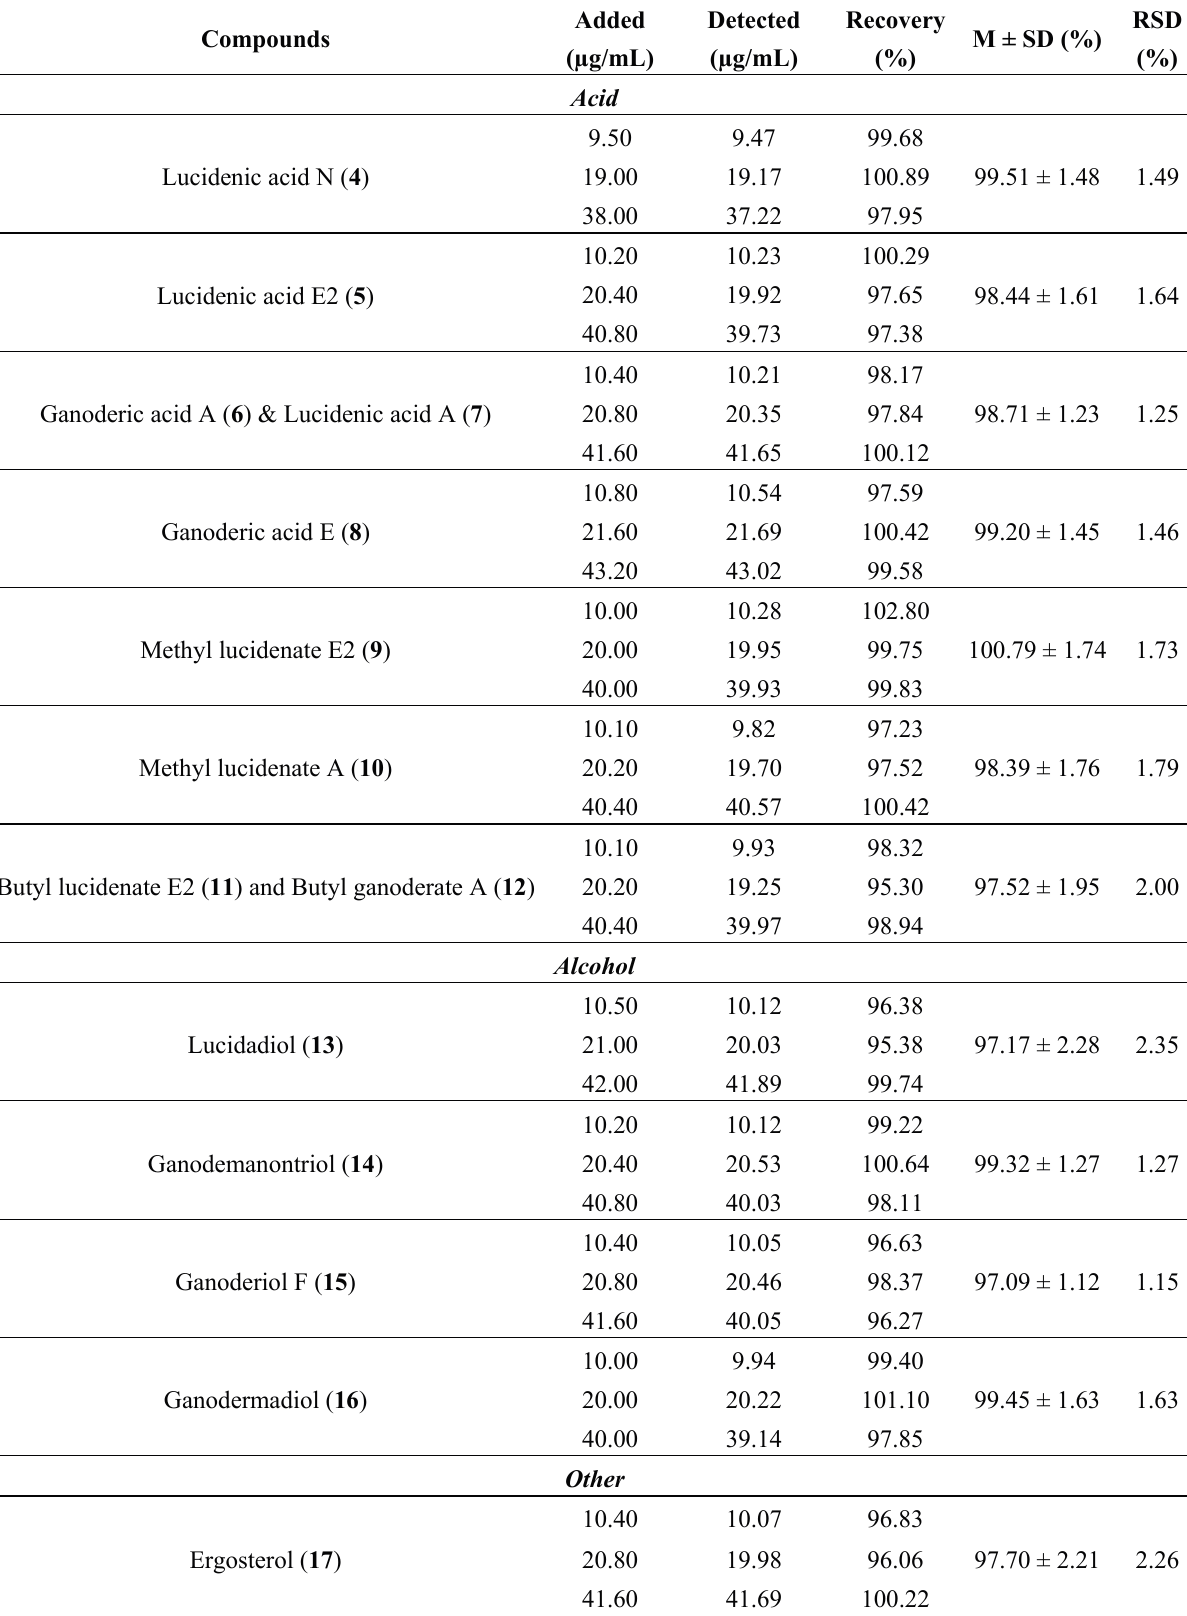
Table 2. Recovery rates of the compounds 4 – 17 from extracts of G. lucidum . Added Compounds